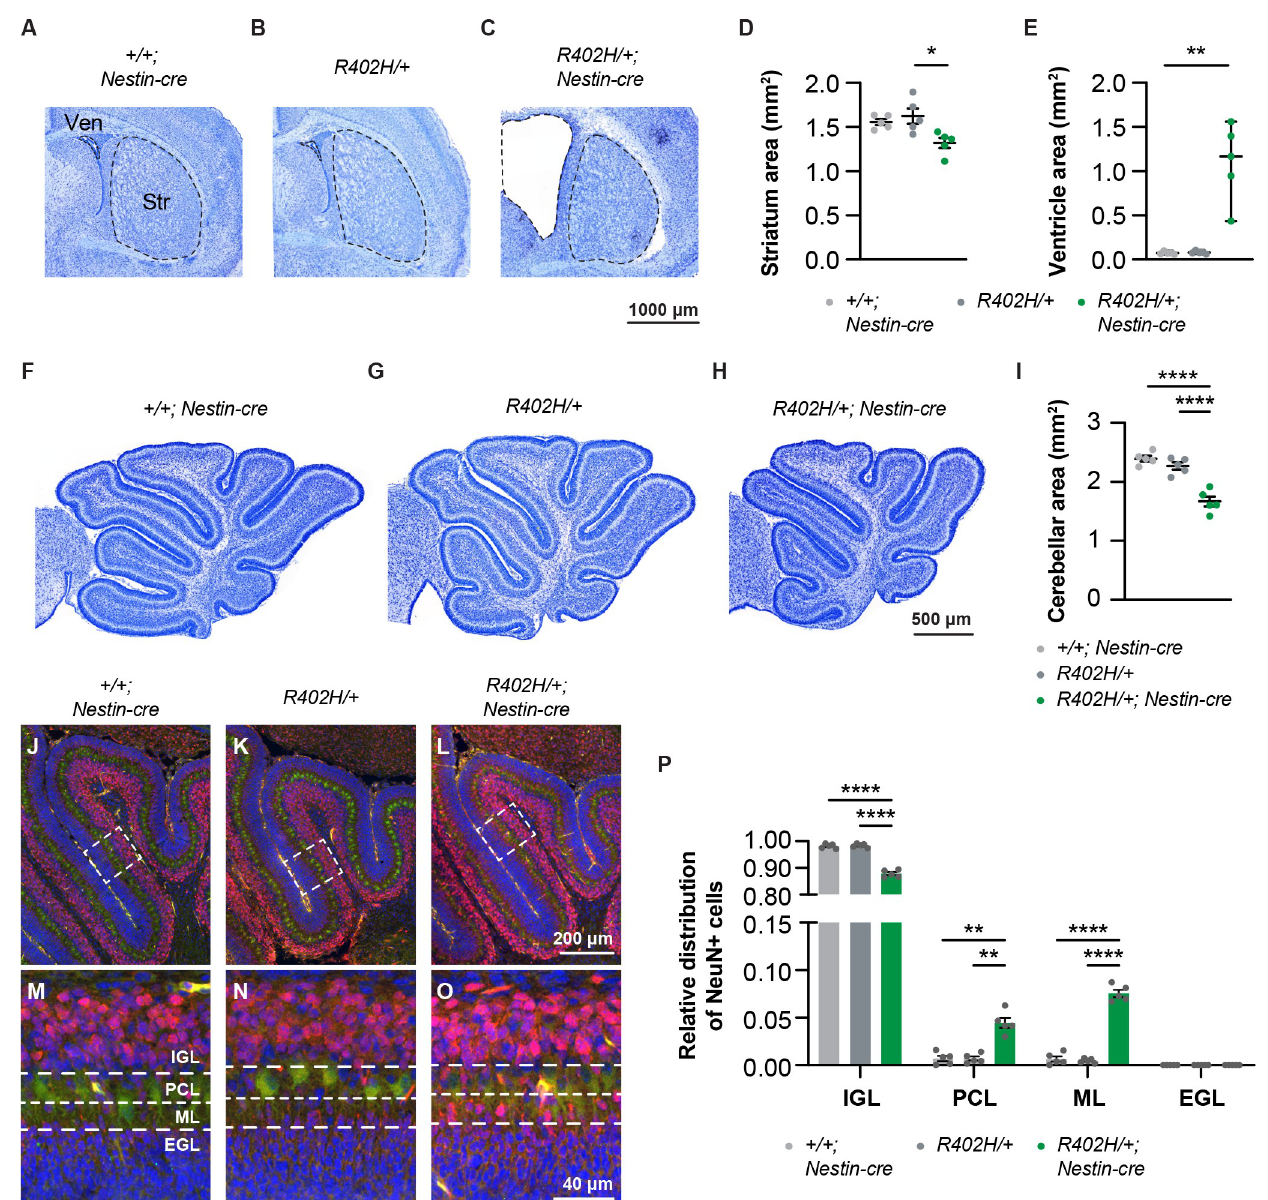
Fig 3. Reduction in striatal size and cerebellar abnormalities in R402H/+; Nestin-cre mice. R402H/+ animals were crossed with a pan neuronal Nestin- cre driver line. (A-C) Representative coronal brain sections of +/+; Nestin-cre controls, R402H/+ controls, and R402H/+; Nestin-cre mutants at post-natal day 6 (P6) stained with Nissl. Dashed lines indicate the area measured for the ventricles (Ven) and striatum (Str). (D-E) Quantification revealed a significant difference in the striatal (D) and ventricular area (E) when comparing +/+; Nestin-cre controls, R402H/+ controls, and R402H/+; Nestin-cre mutants (n = 5, striatum: R402H/+ vs. R402H/+; Nestin-cre P < 0.05, ventricle: +/+; Nestin-cre vs. R402H/+; Nestin-cre P < 0.01). (F-H) Representative sagittal sections of the cerebellum at P6. (I) R402H/+; Nestin-cre mutants show a significant reduction of the cerebellar area compared to controls (n = 5, R402H/+ vs. R402H/+; Nestin-cre P < 0.0001). (J-L) Representative cerebellar sagittal sections at P6 in which Purkinje cells were labeled with Calbindin (green) and neurons with NEUN (red). Sections were also counterstained with DAPI (in blue). (M-O) Enlargements of the boxed areas shown in (J-L). The internal granular layer (IGL), Purkinje cell layer (PCL), molecular layer (ML) and external granular layer (EGL) are marked. (P) Relative distribution of NEUN-positive neurons in the four layers of the cerebellum. There is a significant reduction in NEUN-positive cells found in the IGL and a significant increase in both the PCL and ML, in R402H/+; Nestin-cre mutants compared to littermate controls (n = 5, IGL: R402H/+ vs. R402H/+; Nestin-cre P < 0.0001, PCL: R402H/+ vs. R402H/+; Nestin-cre P < 0.01 and ML: R402H/+ vs. R402H/+; Nestin-cre P < 0.0001). In all panels +/+; Nestin-cre controls are shown in light grey, R402H/+ controls in dark grey and R402H/+; Nestin-cre mutants in green. Error bars show the mean ± s.e.m. except for E, where data is represented as median ± 95% CI. � P < 0.05, �� P < 0.01, ���� P < 0.0001. Scale bars show 1000 μ m in C, 500 μ m in H, 200 μ m in L and 40 μ m in O.